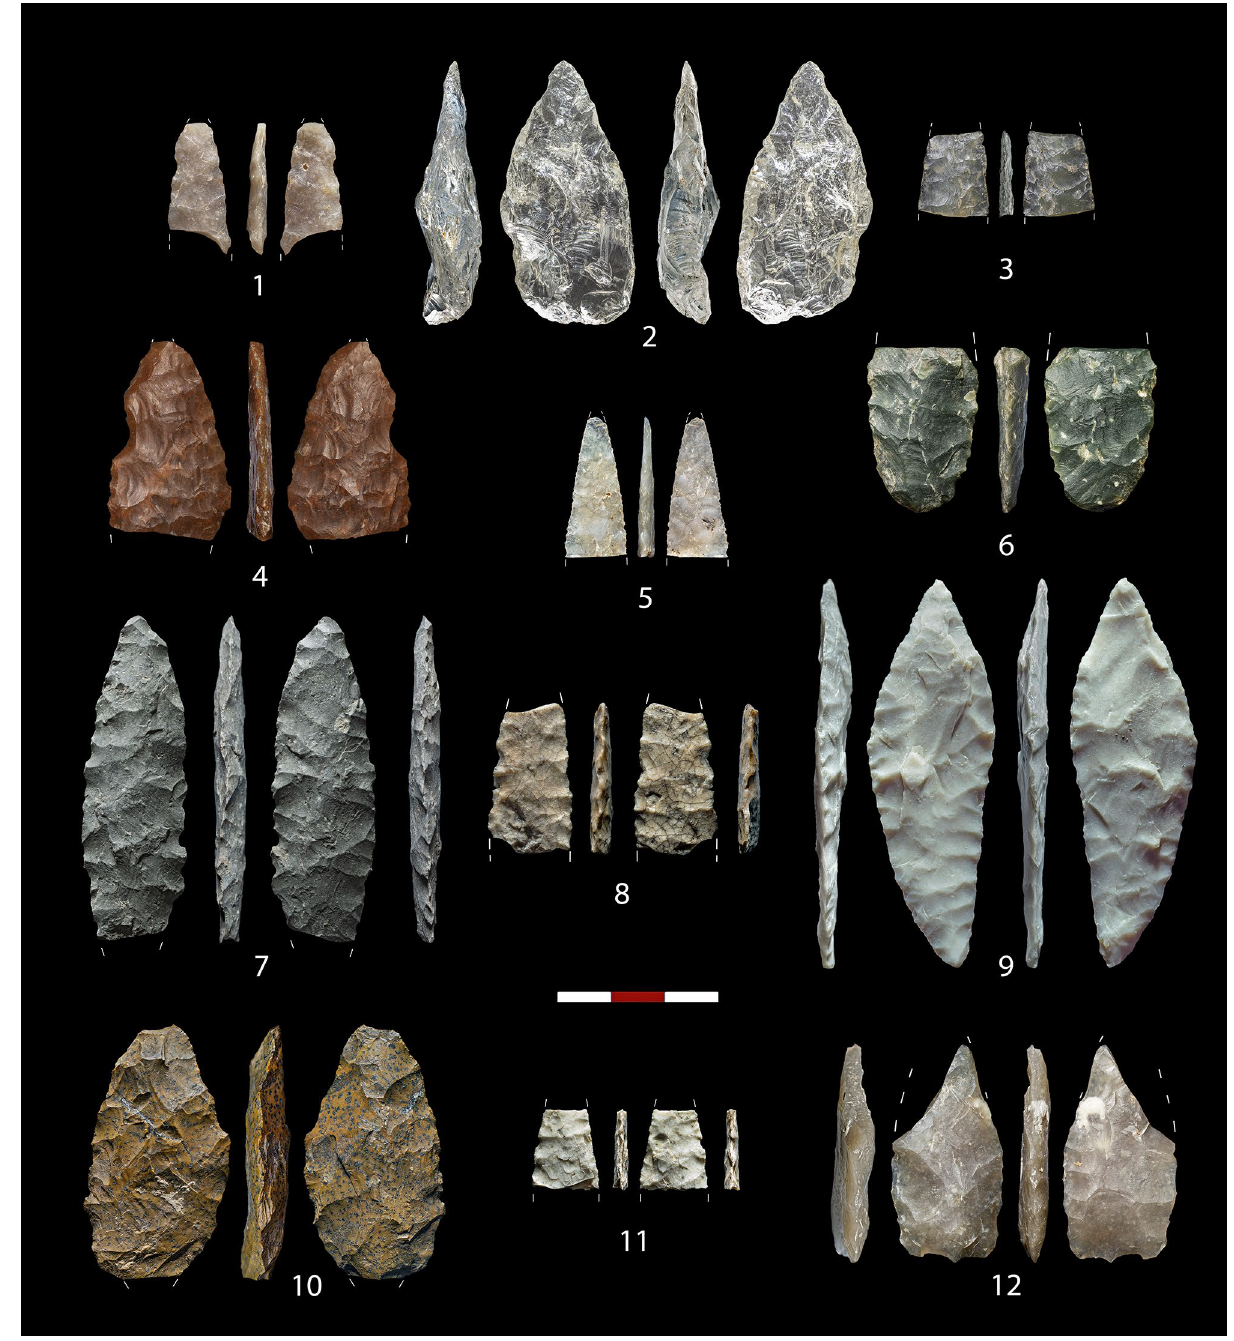
Figure 9. Solutrean lithic assemblages. Level 1: 1–3. Level 2a: 4–6. Level 2b: 7–9. Level 3: